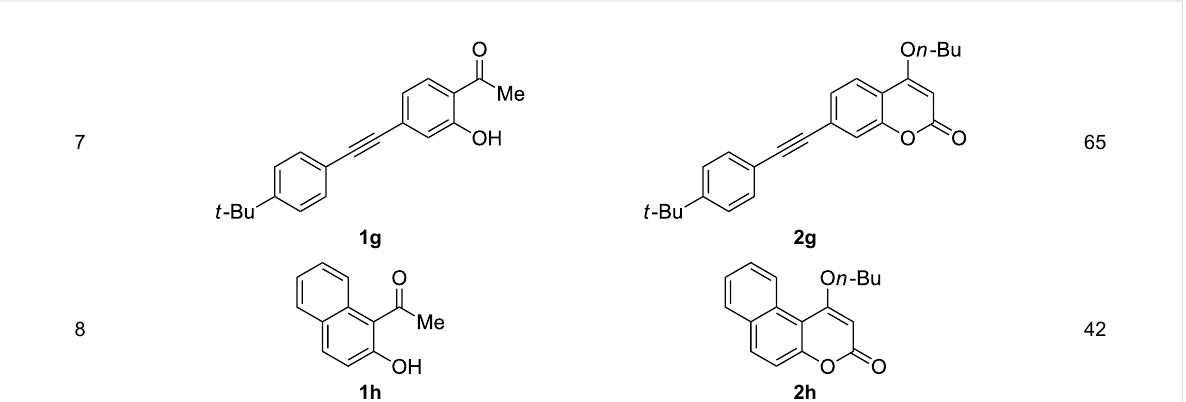
Table 2: Carboxylative cyclization of various o -hydroxyacetophenones with carbon dioxide. a (continued)